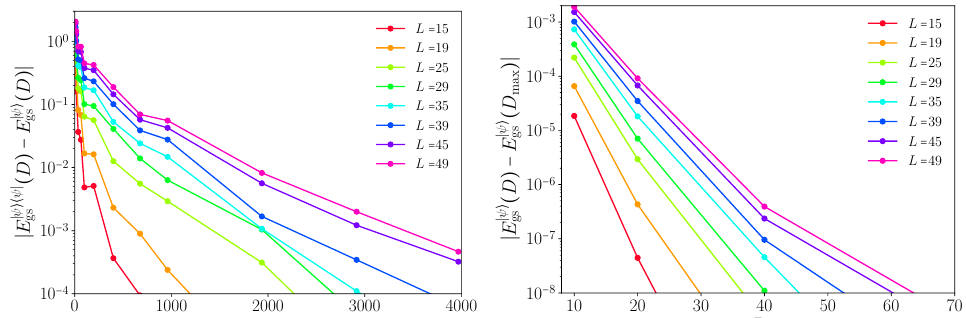
Figure 17: (left panel) Deviation of ground state energy after purification from the value obtained by DMRG in the original Hilbert space for different system size L . (right panel) The difference between ground state energy obtained by DMRG in the original Hilbert space for two bond dimensions D and D dimension fulfills truncation error ε = 10 − 12 and varies from D = 90 for system size L = 49. The ground state has been calculated size L = 15 to D max / J = for J z x